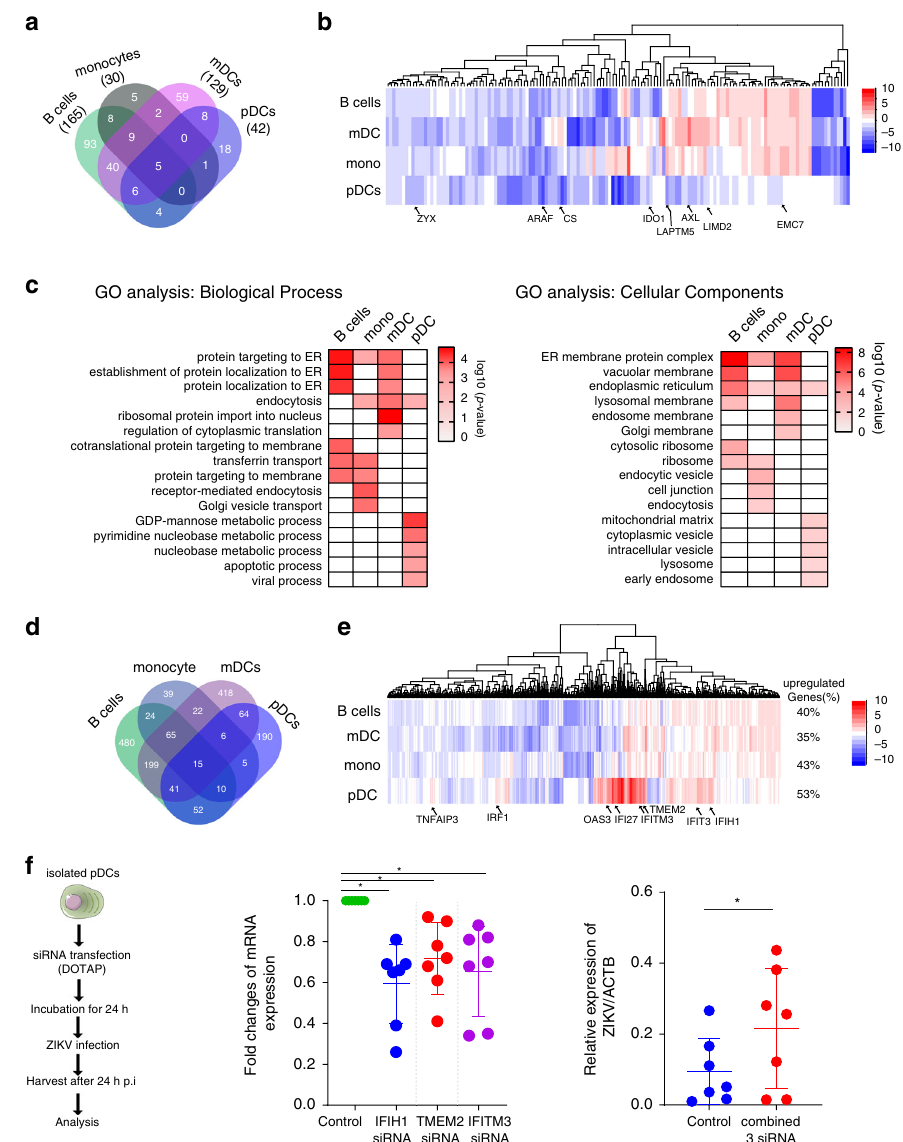
Fig. 3 Differential expression of ZIKV-dependency genes and interferon-stimulated genes in pDCs from ZIKV-infected patients. a Venn Diagram indicating the number of previously described ZIKV-dependency genes that meet criteria for differential gene expression between ZIKV-infected patients and noninfected individuals in indicated cell populations. b Heatmap re fl ecting expression patterns of selected ZIKV-dependency genes in indicated cell populations. c Computational Gene Ontology (GO) analysis of differentially expressed ZIKV-dependency genes in indicated cell populations, as determined using WebGestalt 66 . d Venn diagram re fl ecting the frequency of Interferon-stimulated genes (ISGs) meeting criteria for differential expression between ZIKV patients and controls in indicated cell populations. e Heatmap indicating expression patterns of ISGs meeting criteria for differential expression between ZIKV-infected patients and noninfected individuals in indicated cell populations. Proportion of upregulated/downregulated ISGs in each cell compartment is indicated. f Left panel: Graphical representation of in vitro ZIKV infection experiments following siRNA-mediated gene silencing in isolated pDCs. (middle panel): relative mRNA expression of IFIH1 , TMEM2 , and IFITM3 mRNA in pDCs at 24 h after transfection with indicated siRNAs. Right panel: Expression of ZIKV RNA relative to β -actin mRNA in pDCs transfected with a cocktail of gene-speci fi c siRNAs (targeting IFIH1 , TMEM2 , and IFITM3 ) or control siRNA ( n = 7 biologically independent samples). Horizontal lines re fl ect mean ± SD. Statistical signi fi cance between the different subsets was tested using a Friedman test with post-hoc Dunn ’ s test. NS, not signi fi cant; * p <